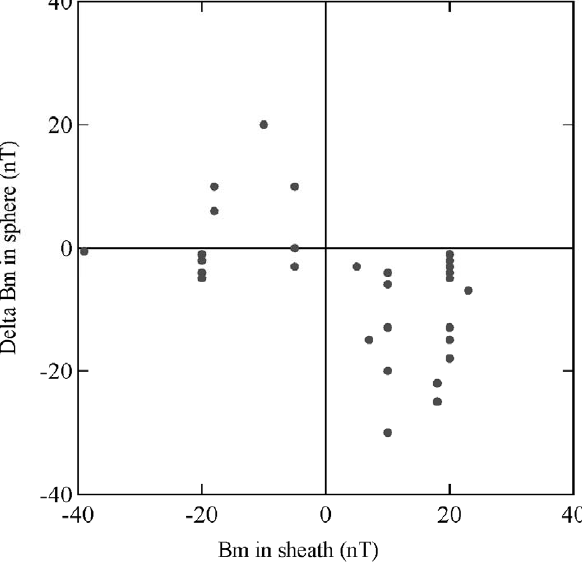
Fig. 13. Magnitude of the east/west (Bm) perturbation observed within magnetosphere FTEs versus Bm in the magnetosheath at the nearest magnetopause